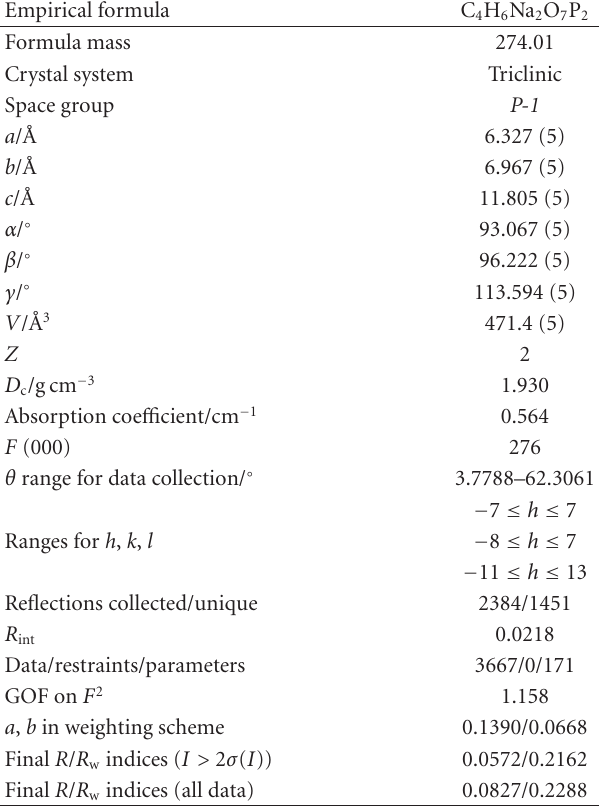
Table 1: Crystallographic and experimental data for